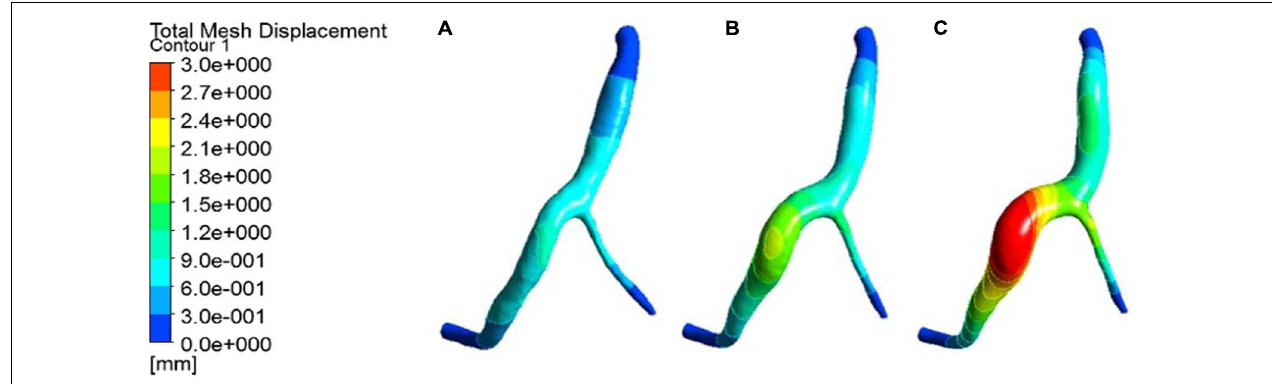
FIGURE 5 | Deformation contour of the RCA in maximum time. (A) normal condition; (B) the Young’s modulus of the atherosclerotic site is 0.27MPa; (C) the Young’s modulus of the atherosclerotic site is 0.027 MPa.